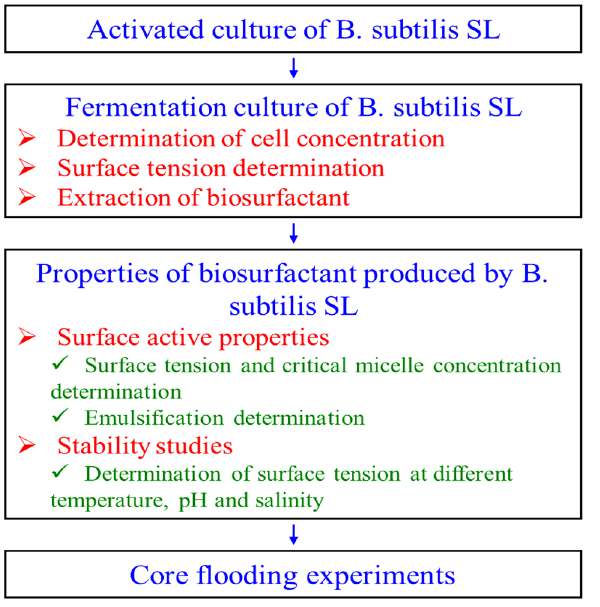
Figure 1. Research method